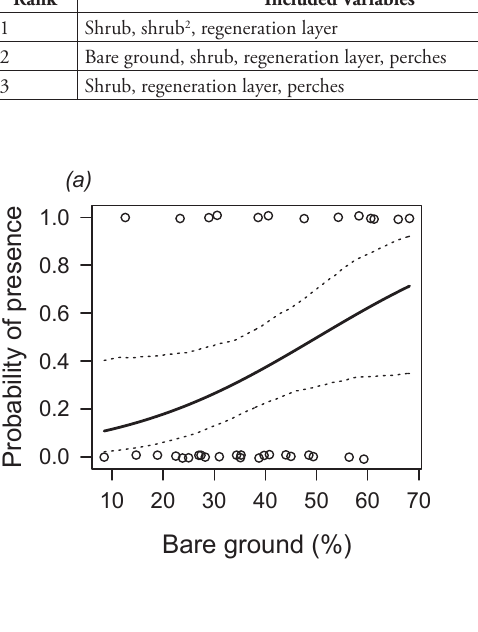
Table 3. The three most competitive models (∆AICc <2). The ranking is based on the AIC. Rank Included Variables AICc ∆AICc R 2 1 32.8